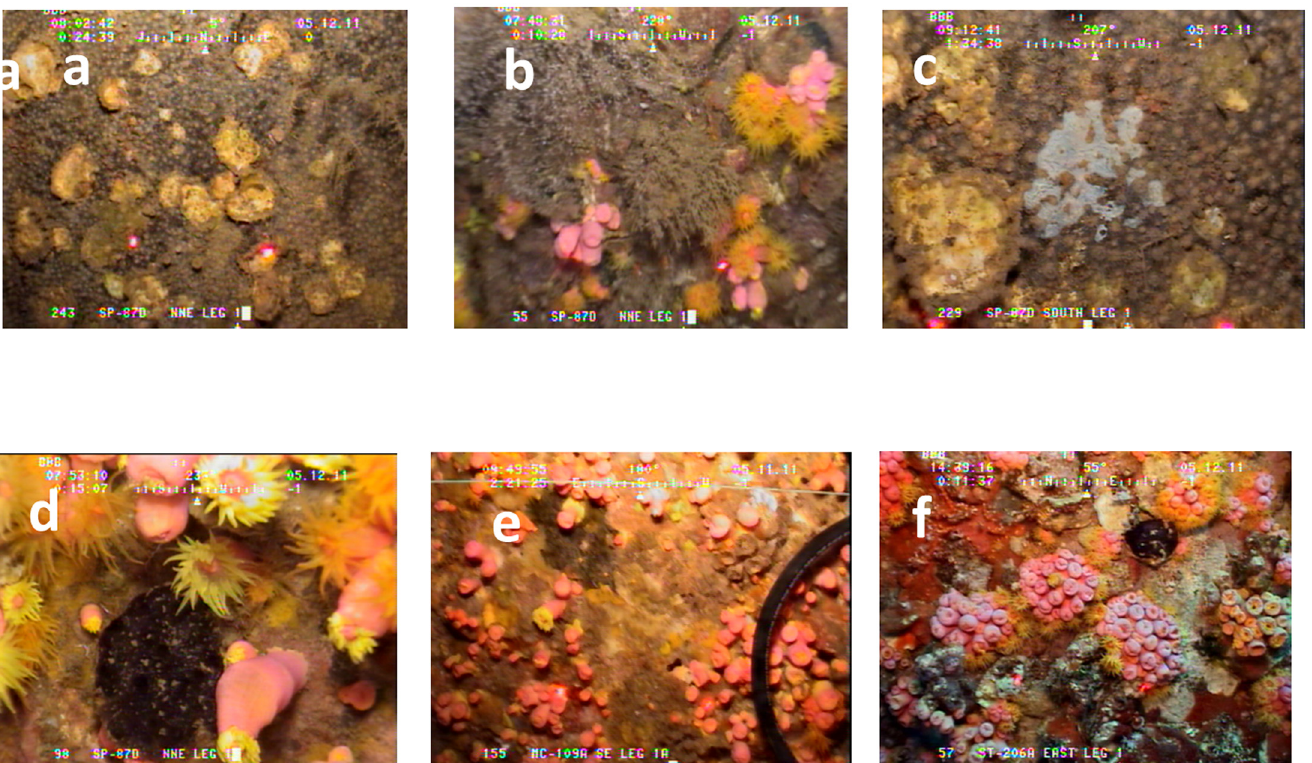
Fig 6. Photographs of the six most abundant competitors of space against Tubastraea coccinea on oil/gas platforms in the study region, northern Gulf of Mexico. Photos are still-captures from an ROV video. a = Xestospongia sp. with commensal zoanthids Parazoanthus catenularis ; b = Dictyonella funicularis ; c = Haliclona vansoesti ; d = Xestospongia carbonaria ; e = Mycale carmigropila ; f = Phorbas amaranthus .